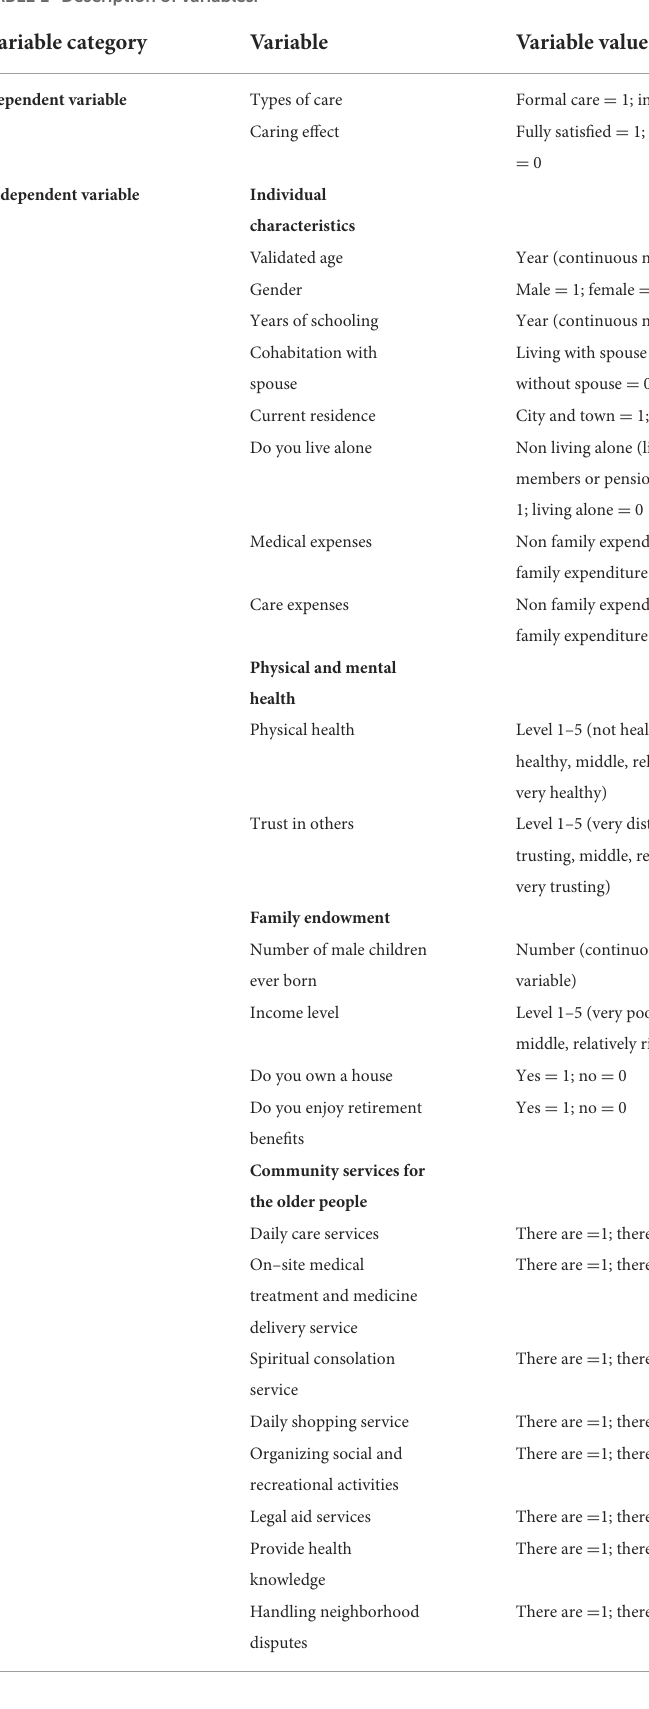
TABLE 1 Description of